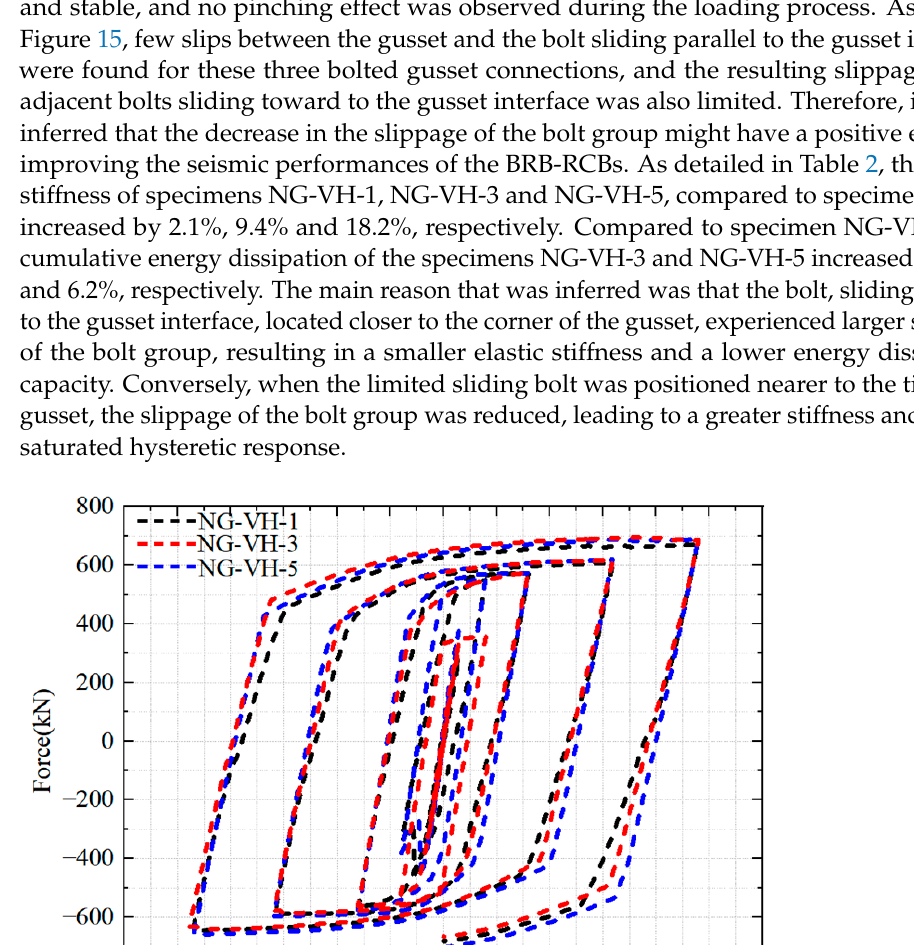
( b ) Figure 13. The Von Mises stress responses along the gusset interfaces at 2% drift: ( a ) Joint closing; ( b ) Joint opening.